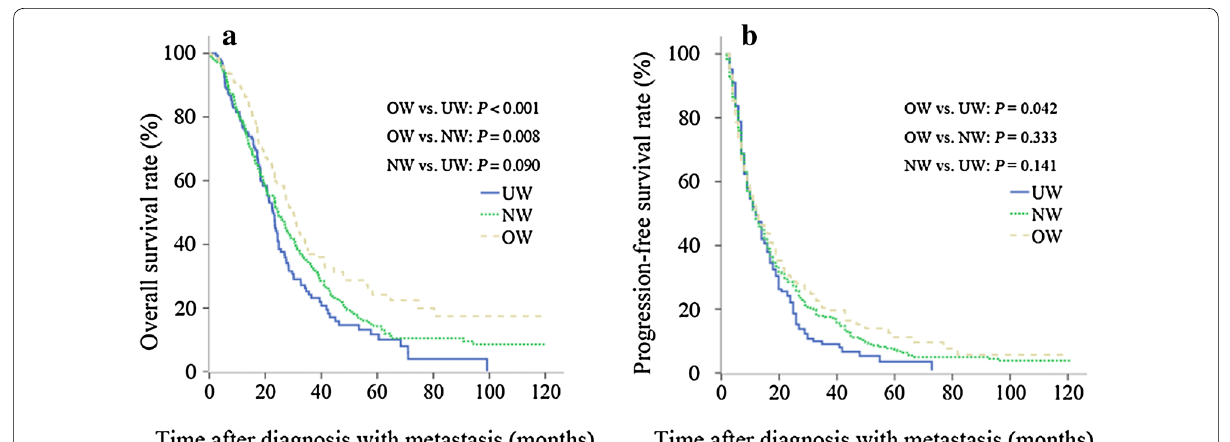
Fig. 1 Overall survival (OS) and progression‑free survival (PFS) for metastatic nasopharyngeal carcinoma (NPC) patients by body mass index (BMI) levels. Overweight/obese patients had significantly higher OS ( a ) and PFS ( b ) rates than underweight patients, whereas no significant differences were observed in OS and PFS between normal weight and underweight patients. UW underweight, NW normal weight, OW